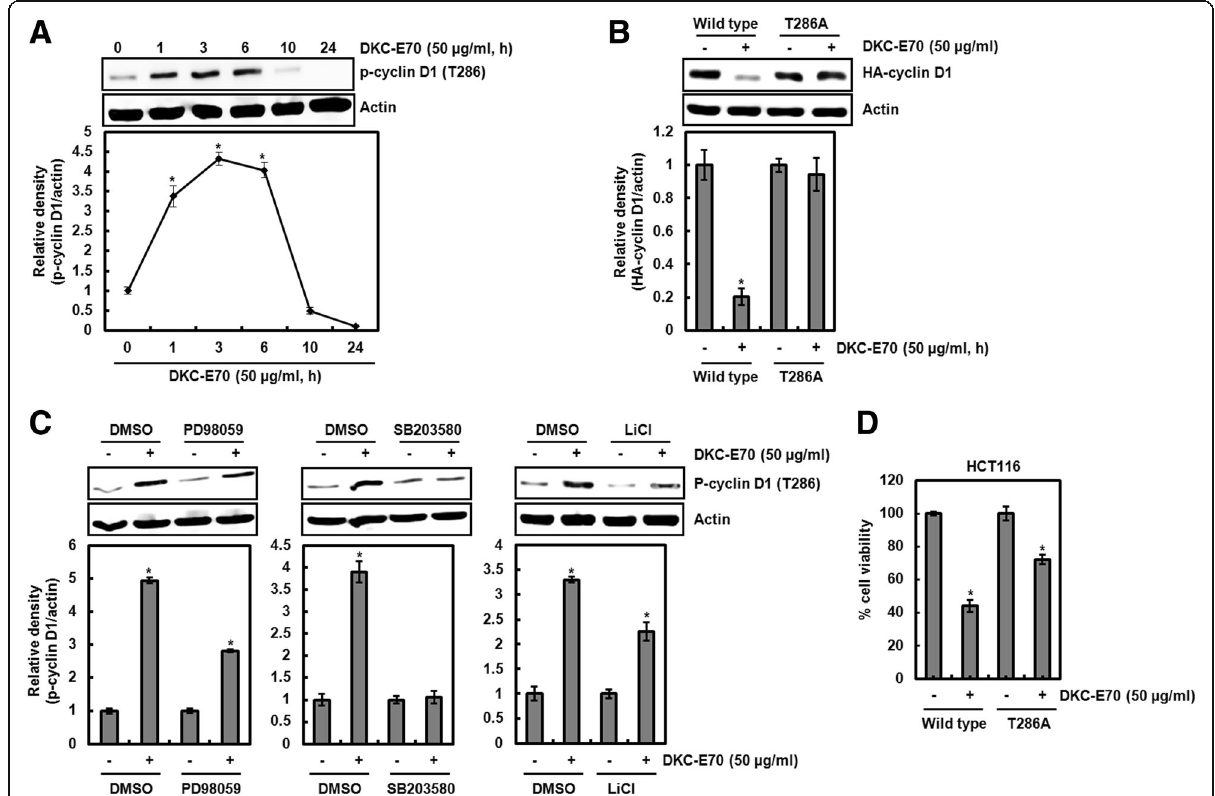
Fig. 5 Cyclin D1 degradation by DKC-E70 is followed by T286 phosphorylation dependent on ERK1/2, p38 and GSK3 β . a HCT116 cells were treated with DKC-E70 (50 μ g/ml) for the indicated times. b HCT116 cells were transfected with wild type HA-tagged cyclin D1 or HA-tagged T286A cyclin D1 expression vector for 24 h, and then treated with DKC-E70 (50 μ g/ml) for 10 h. c HCT116 cells were pretreated with PD98059 (40 μ M) as an ERK1/2 inhibitor, SB203580 (40 μ M) as a p38 inhibitor or LiCl (20 mM) as a GSK3 β inhibitor, and then co-treated with DKC-E70 (50 μ g/ml) for 3 h. Cell lysates were subjected to SDS-PAGE and the Western blot was performed using antibodies against p-cyclin D1 (T286) or HA-cyclin D1. Actin was used as internal control for Western blot analysis. *P < 0.05 compared to cell without DKC-E70 treatment. d HCT116 cells were transfected with wild type HA-tagged cyclin D1 or HA-tagged T286A cyclin D1 expression vector for 24 h, and then treated with DKC-E70 (50 μ g/ml) for 24 h. Cell viability was measured using MTT assay. *P < 0.05 compared to cell without